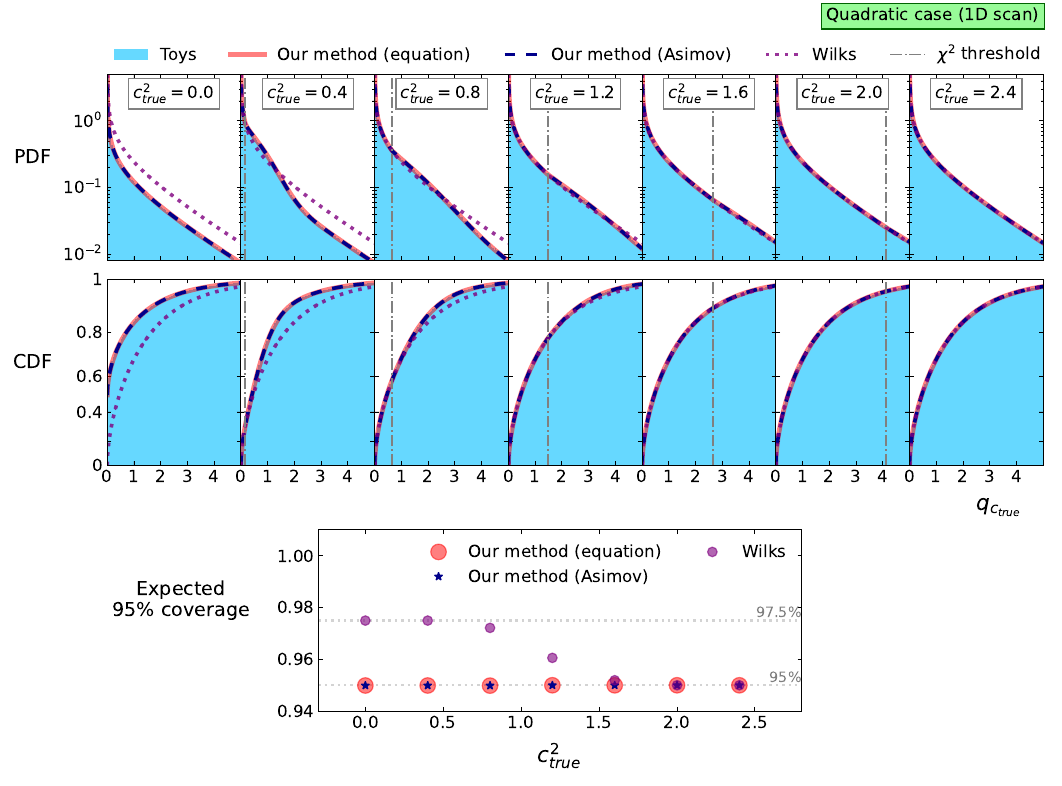
Figure 3: Demonstration of the validity of our method when considering a single Wilson coefficient which modulates the purely quadratic contributions described by Eq 16. were assumed. A vertical dotted line represents the threshold above which Wilks’ theorem is violated. The second row shows the corresponding cumulative distribution functions (CDFs), which are used to derive p